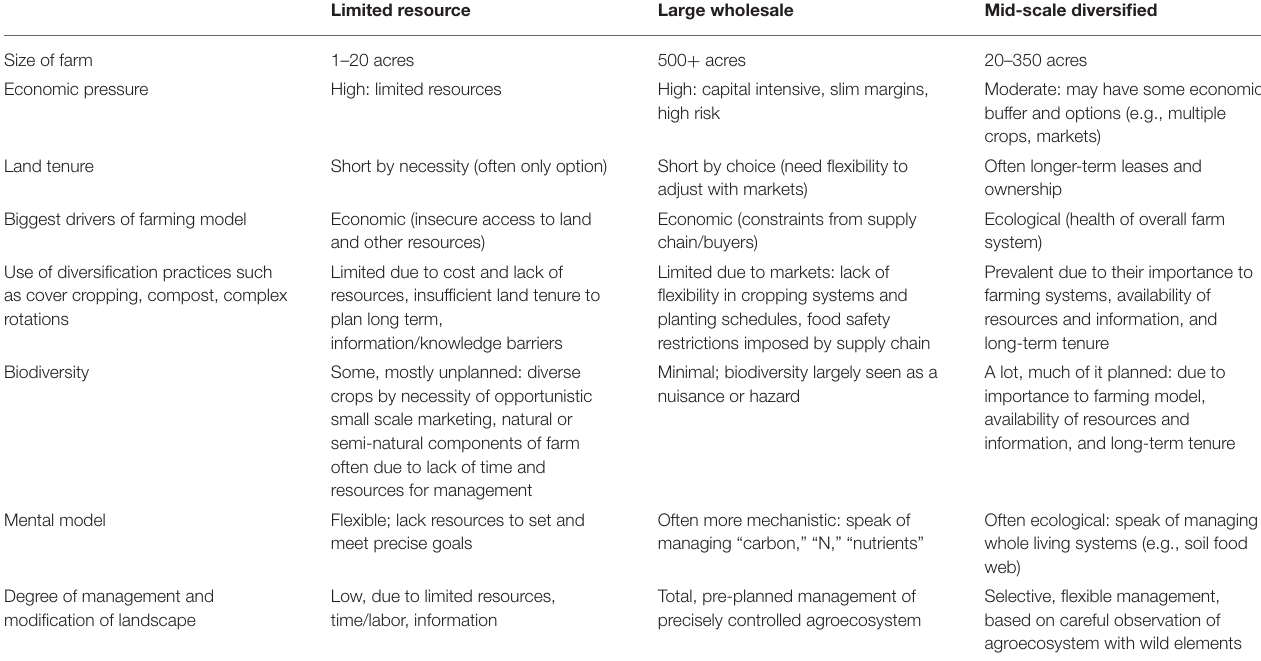
TABLE 2 | Key characteristics of the farming model